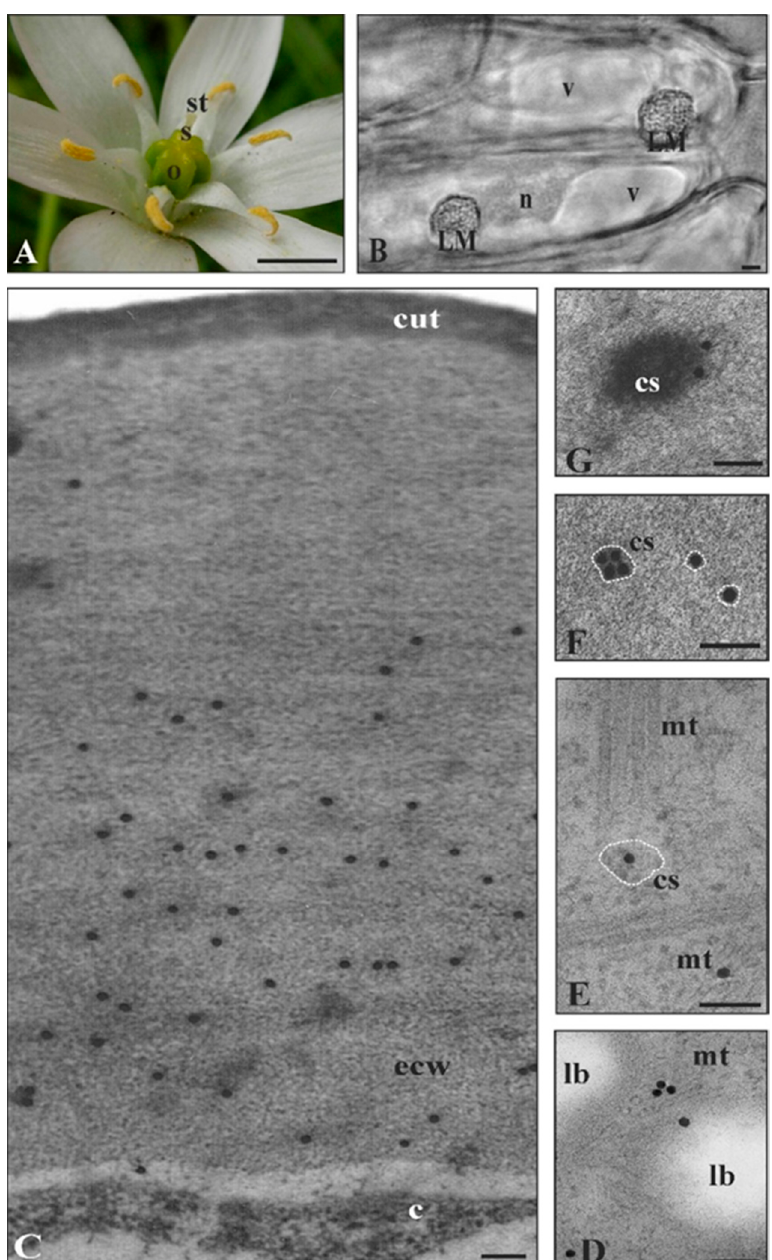
Figure 5. Cutinsome identification and localization in ovary epidermis of O. umbellatum . ( A ) Mature flower with clearly visible ovary. ( B , light microscope image) LMs characteristic of O. umbellatum ovary epidermis, in which cutinsomes are formed. Cutinsomes in the ( D , E ) cytoplasm and ( C , F , G ) external cell wall sections ( C – G ) fixed in glutaraldehyde and without OsO 4 after immunogold reaction with anti-cutinsome antibodies. ( G ) Cutinsomes are visible, (rings; E , F ) barely visible, or ( C , D ) not visible at all but identified by anti-cutinsome antibodies; c, cytoplasm; cs, cutinsome; cut, cuticle; ecw, external cell wall; lb, lipid body; LM, lipotubuloid metabolon; mt, microtubules; n, nucleus; o, ovary; s, style; st, stigma; v, vacuole; Bars, ( A ) 10 mm, ( B ) 10 µm, ( C – G ) 100 nm.